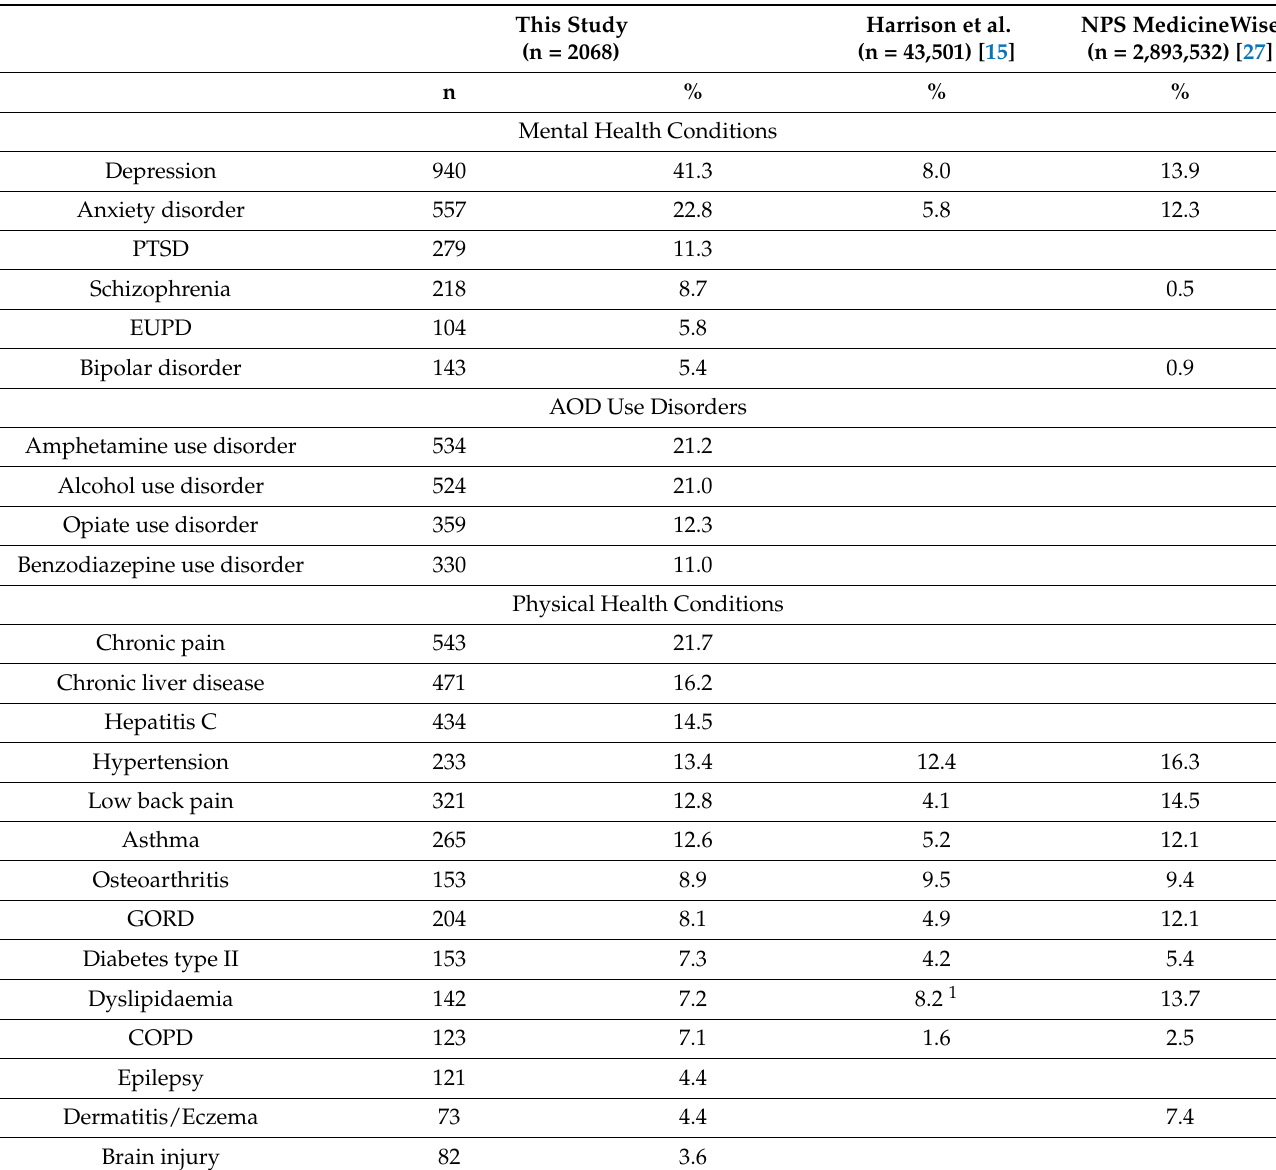
Table 4. Age-adjusted Proportion of General Practice Patients with “ever recorded” Condition–Comparison to General Australian Population